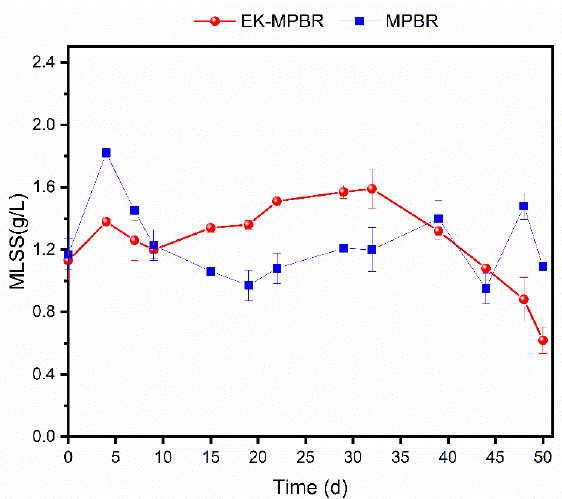
Figure 2. Variation of biomass production for MPBR with and without applied electric field over the experimental period.